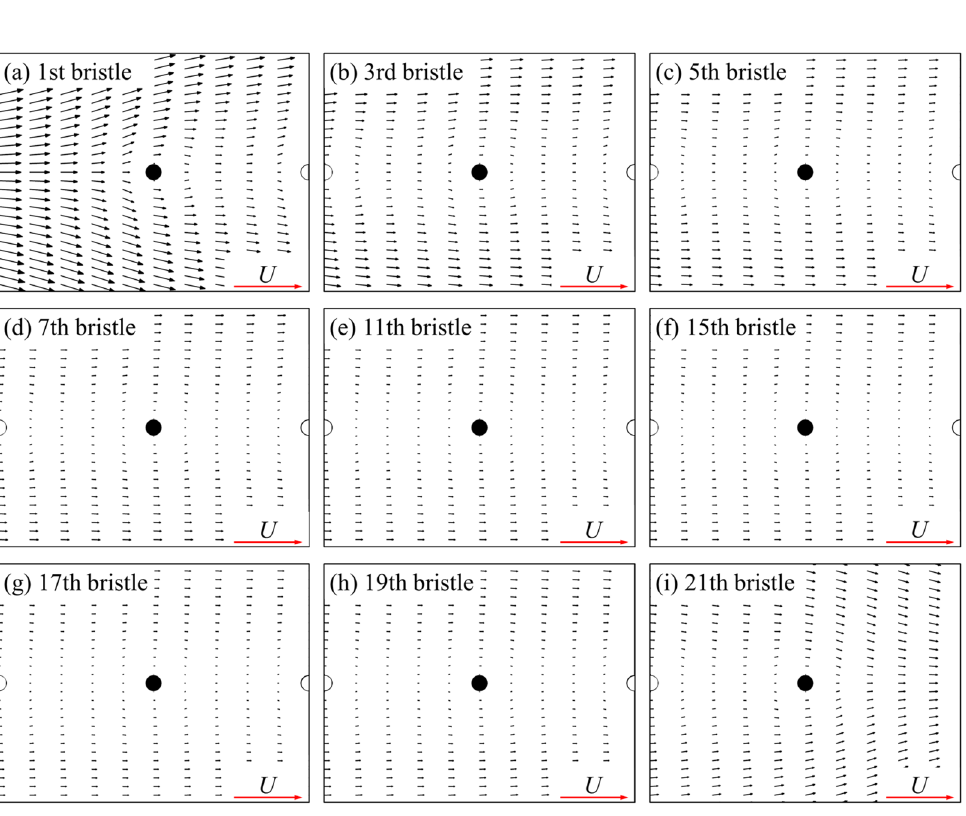
Figure 11. The plot of non-dimensional velocity vector around ( a ) the first, ( b ) the third, ( c ) the fifth, ( d ) the seventh, ( e ) the eleventh, ( f ) the fifteenth, ( g ) the seventeenth, ( h ) the nineteenth and ( i ) the twenty-first bristle of a single bristled